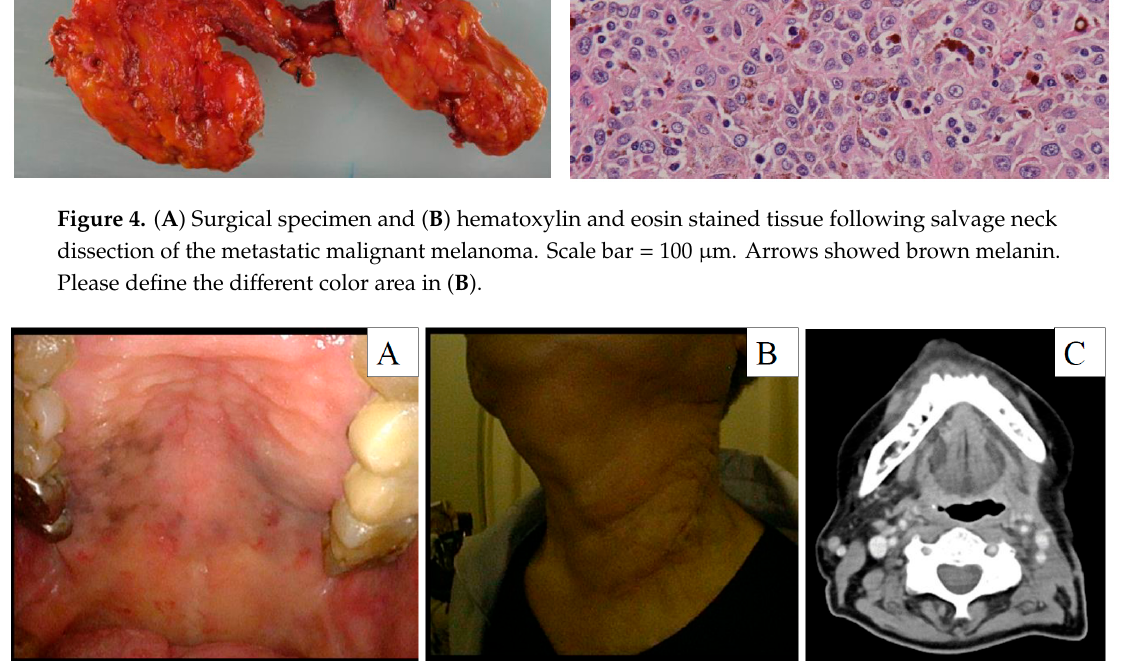
Figure 5. ( A ) White light images of the palate and ( B ) left neck and ( C ) enhanced computed tomography at 3 months after salvage neck dissection.